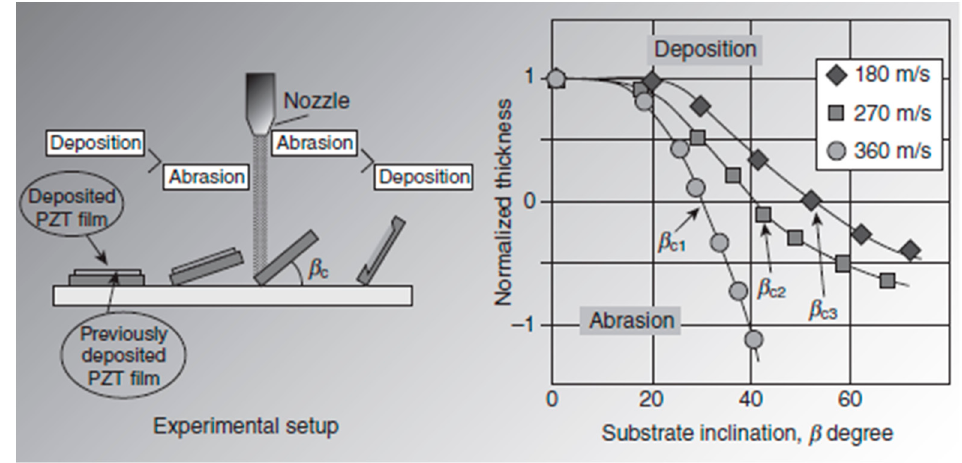
Figure 19. Particle jet flow angle of incidence effect on deposition properties [2]. © Copyright 2008, J. Therm. Spray Technol.